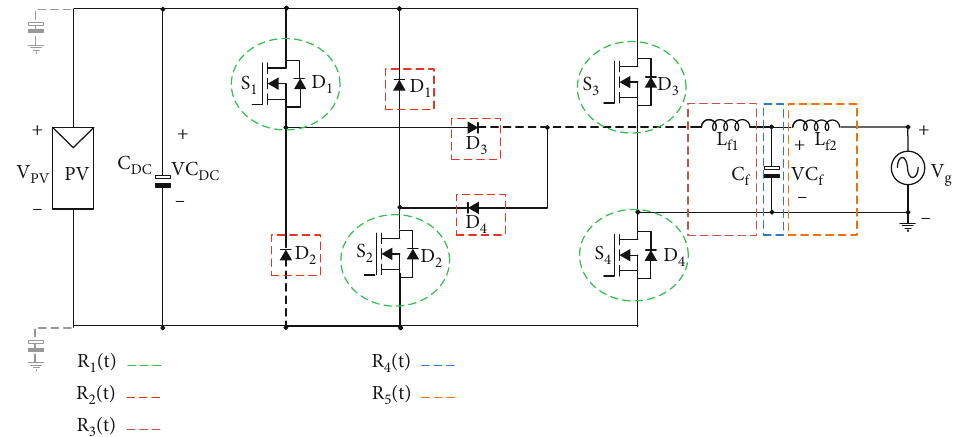
Figure 8: Serial analysis of the double buck inverter.